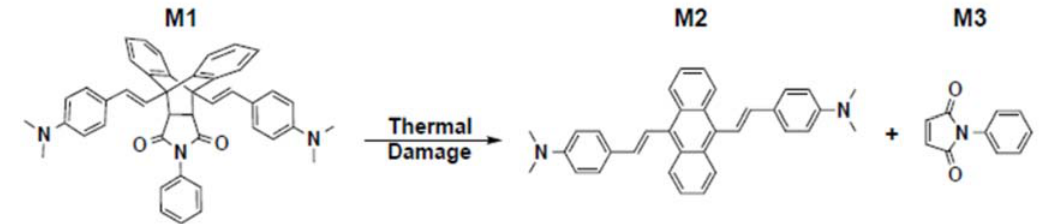
Figure 1. Molecule M1 before and after damage ‐ causing thermal exposures.